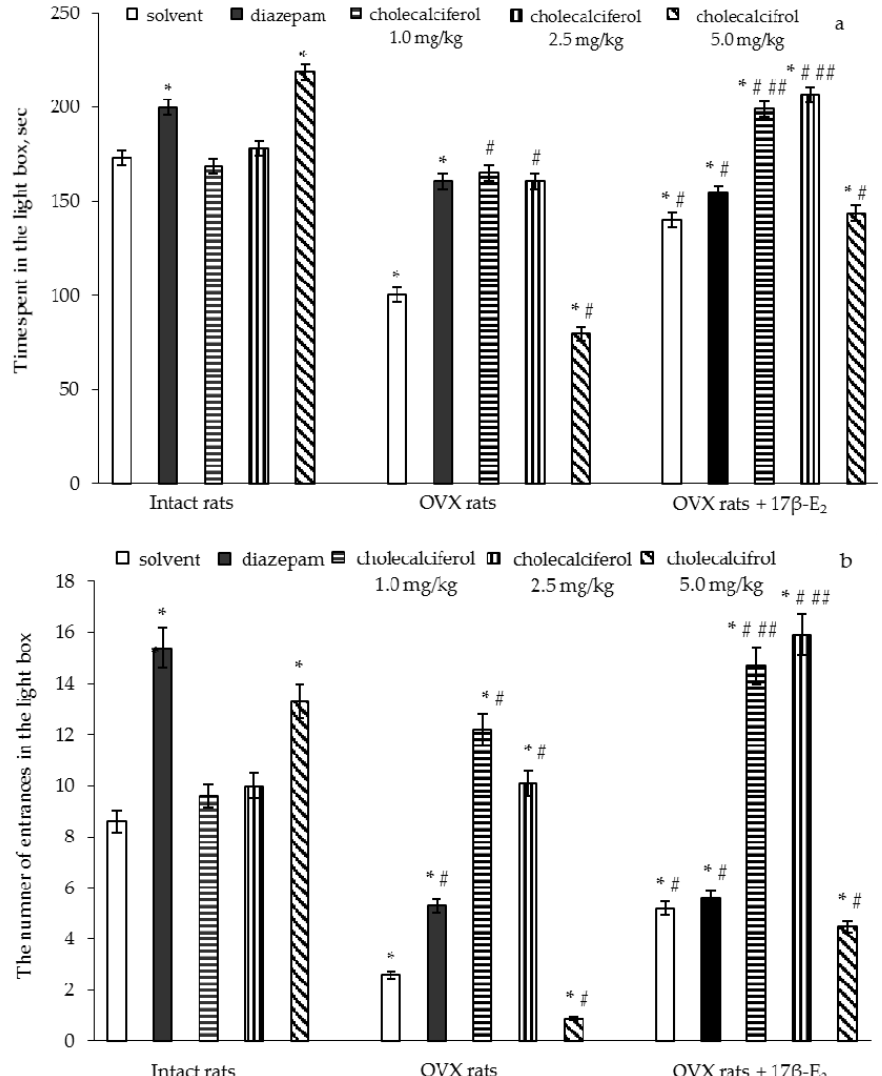
Figure 2. Effects of cholecalciferol administration on anxiety-like behavior of OVX rats following long-term estrogen deficiency in the light/dark test. ( a )—time spent in the light box, sec; ( b )—the number of entrances in the light box. The obtained results show the mean ± standard error of the mean (SEM). *— p < 0.05 as compared to the control group of sham-operated rats, #— p < 0.05 as compared to the OVX rats treated with solvent, ##— p < 0.05 as compared to the OVX rats treated with 17 β -estradiol. Each group comprised a minimum of eight rats. Cholecalciferol was given at 1.0, 2.5 or 5.0 mg/kg/day SC, once daily, for 14 days. The administered dose of 17 β -estradiol (17 β -E 2 ) was 0.5 μ g/rat SC, once daily, for 14 days.